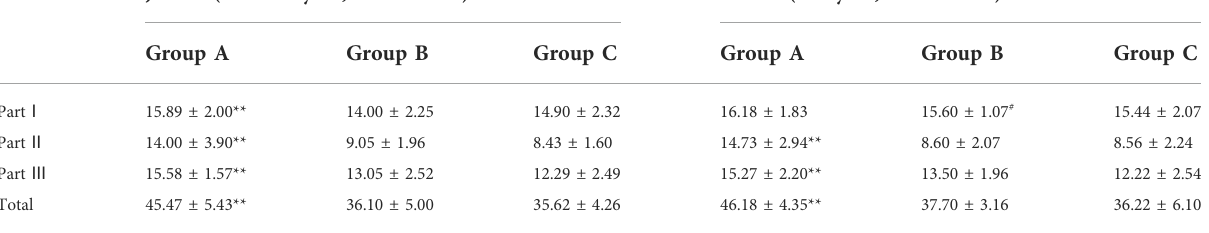
TABLE 6 Comparison of post-lecture scores between junior and senior residents.